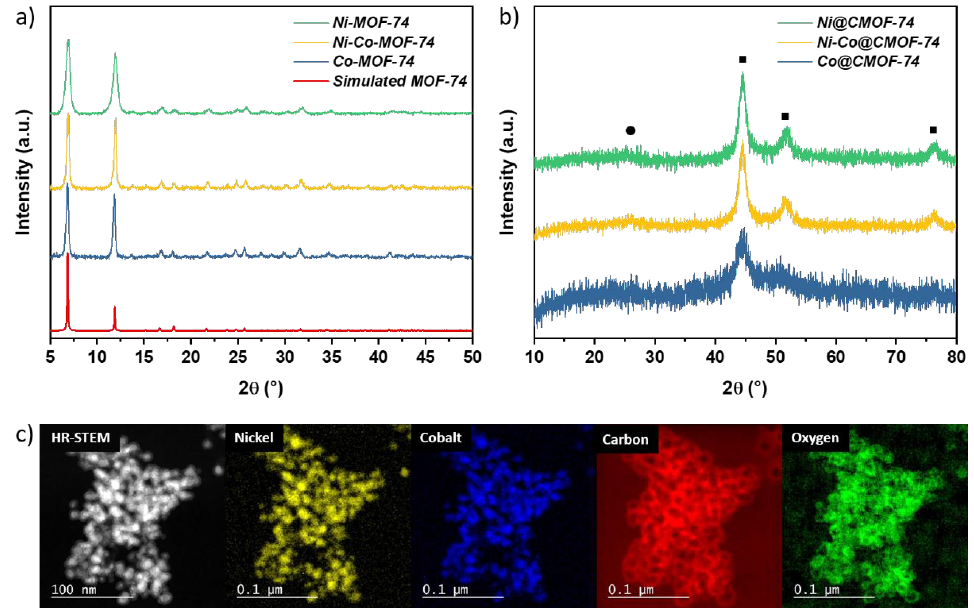
Figure 1. ( a ) Powder X-ray diffraction (PXRD) patterns of M-MOF-74 powders as compared to the corresponding simulated powder pattern of MOF-74; ( b ) powder X-ray diffraction (PXRD) patterns of M@CMOF-74 powders (•-graphite, ▪-MNP) and ( c ) high-resolution dark field scanning transmission electron microscopy (STEM) image of Ni-Co@CMOF-74 catalyst and electron energy loss spectroscopy (EELS) mapping showing the distribution of Ni (yellow), Co (blue), C (red) and O (green).